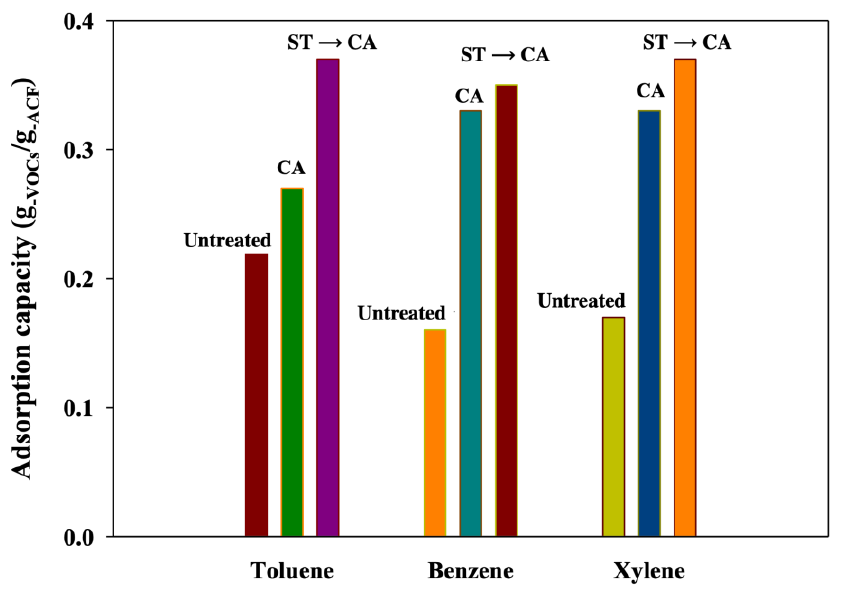
Figure 8. Adsorption capacity in BTX gas adsorption process with ACFs (Untreated, untreated ACFs;